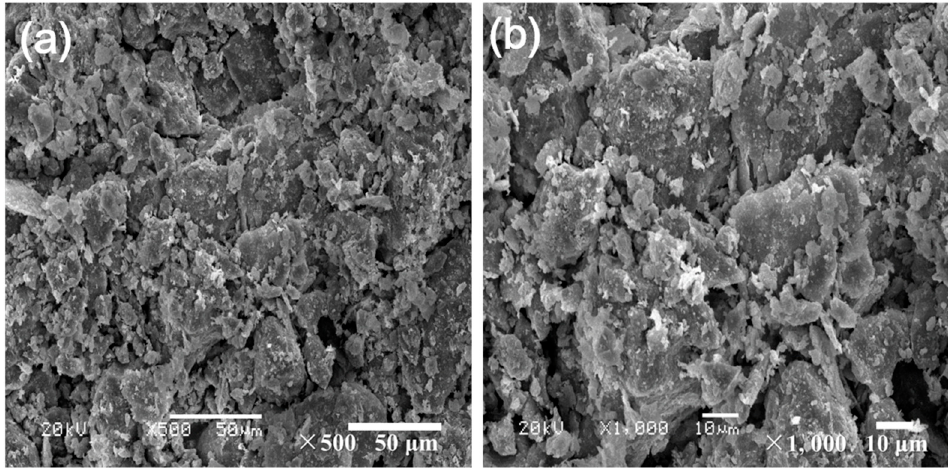
Figure 9. Microstructures of treated loess with 2.0% nano-SiO 2 content after 28 days curing. ( a ) amplification factor of 500; ( b ) amplification factor of 1000.